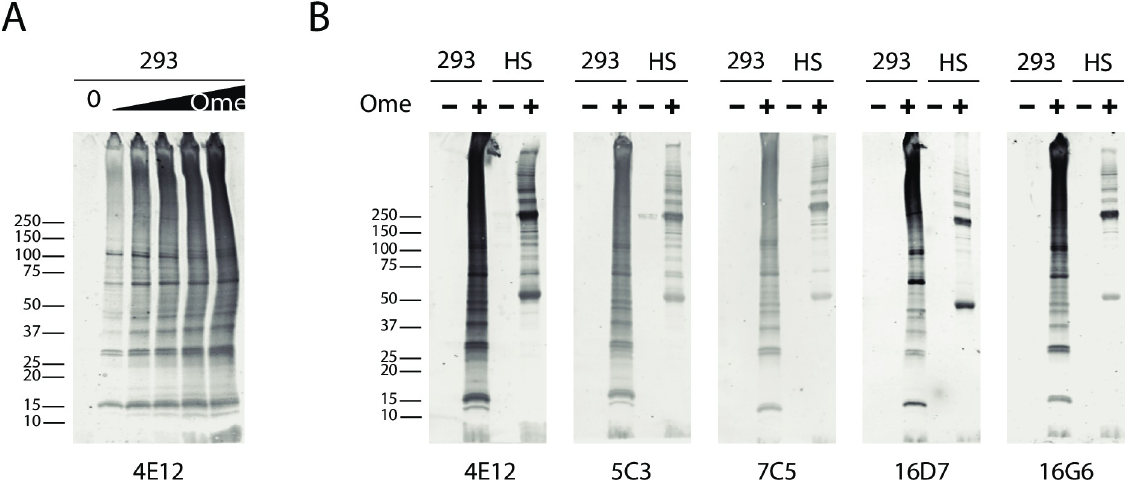
Fig 2. Monoclonal antibody detection of Ome-protein complexes from mammalian cells. (A) HEK293 cell lysates treated with 0, 0.1, 0.25, 0.5, 1, or 2mM omeprazole for 2 hours at 37˚C indicate that the monoclonal antibody 4E12, reacts only with Ome-protein complexes and demonstrates dose dependency. (B) HEK293 lysates (293) and human serum (HS) proteins treated with 2mM omeprazole for 2hr at 37˚C also show that five monoclonal antibodies (4E12, 5C3, 7C5, 16D7, and 16G6) are specific for omeprazole bound mammalian proteins. Samples for SDS-PAGE gel running were boiled in sample buffer without reducing agents. Antibodies were used at 1:50 dilution.